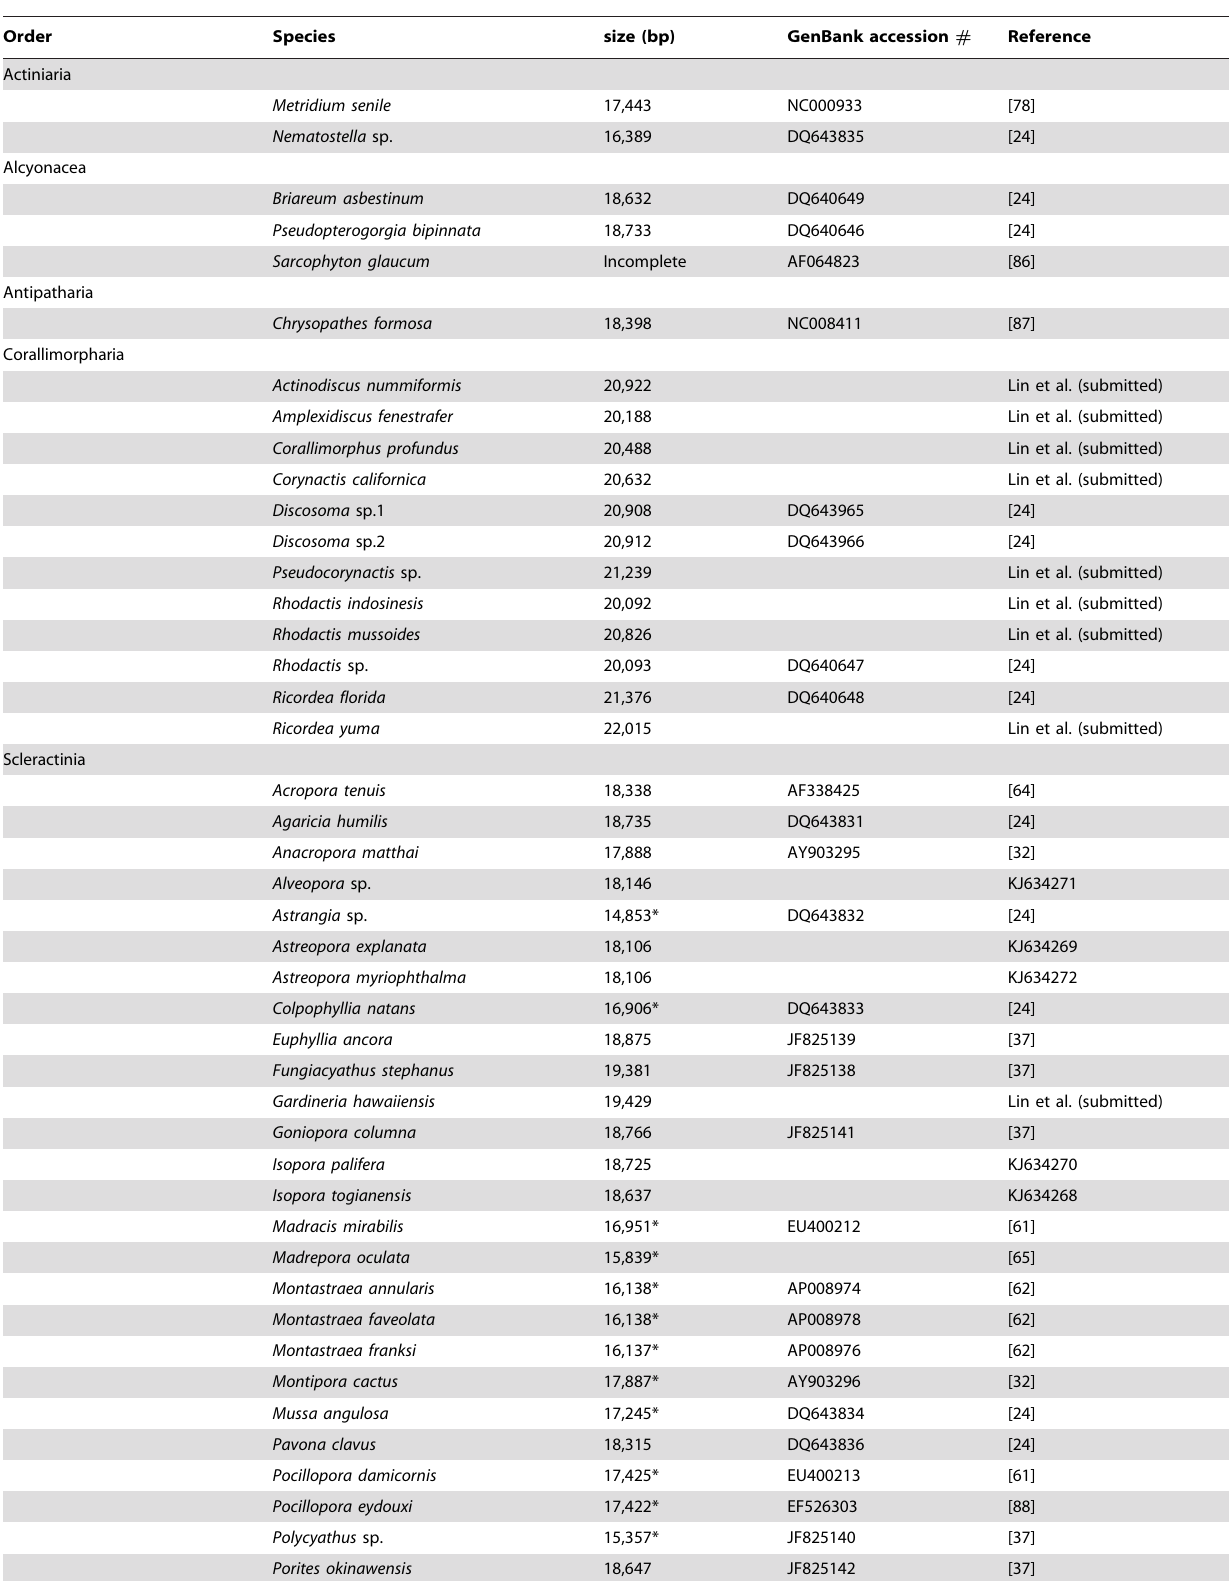
Table 1. Mitochondrial genome sequence data included in the present analyses